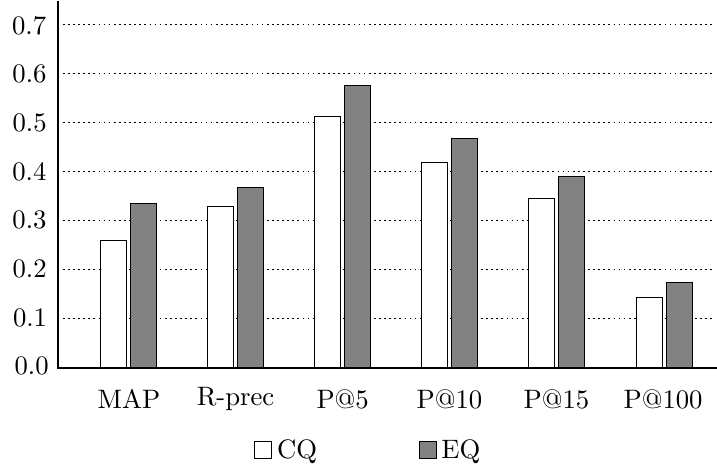
Figure 5. Mean values of measures. Table 1. Measures of the evaluation of the combined and expanded